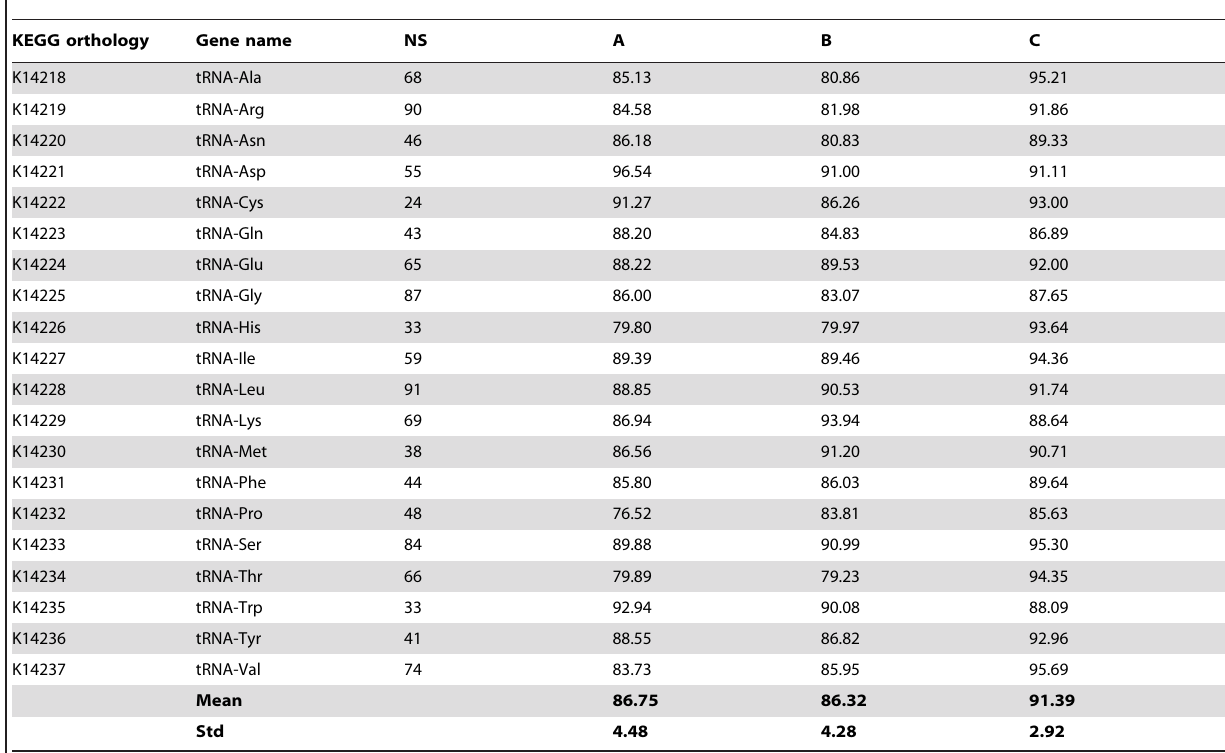
Table 2. Similarity scores of